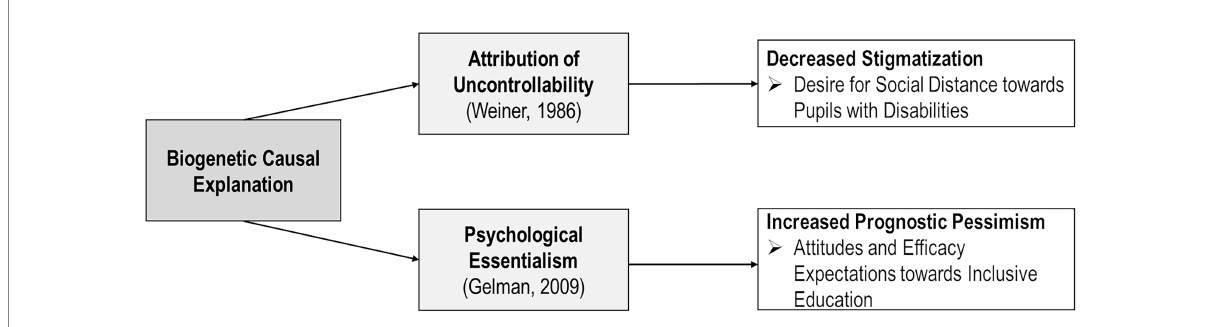
FIGURE 1 Adaptation of the mixed-blessings model to the effect of biogenetic causal explanations on stigmatization, attitudes, and expectations in the context of inclusive